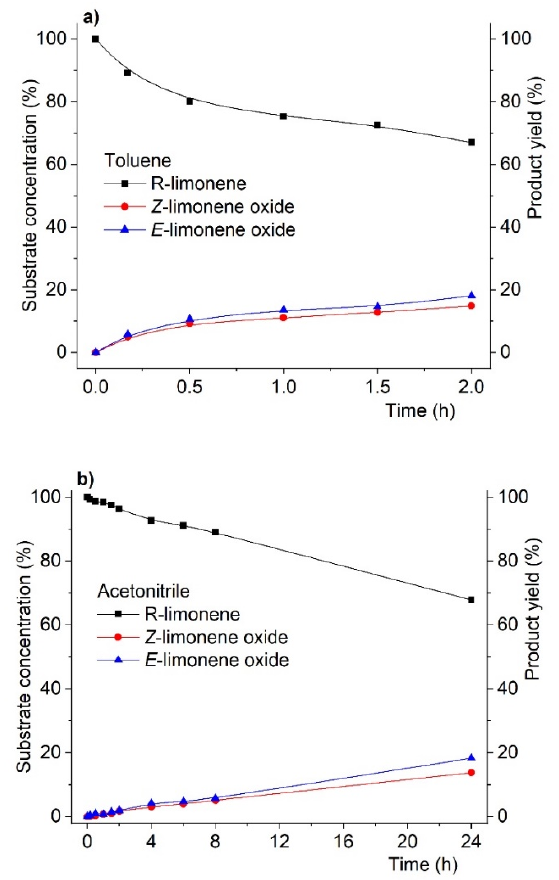
Figure 2. Reaction profiles for R -(+)-limonene oxidation catalyzed by MCM-bpy-Mo catalyst in toluene ( a ) and acetonitrile ( b ) at substrate isoconversion. Reactions were carried out using sub- strate:oxidant:catalyst mol % ratio of 100:200:3 using acetonitrile or toluene as solvent and at 3535